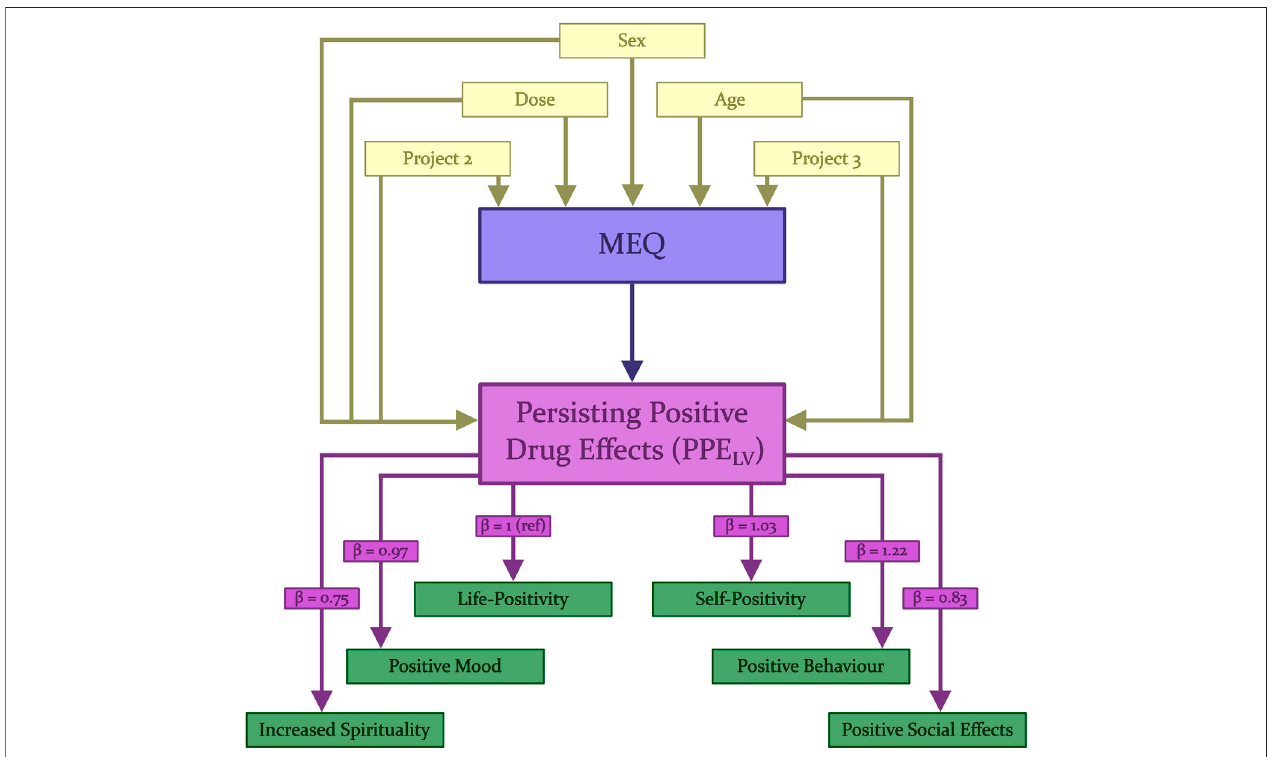
FIGURE1| LatentVariable Model. Schematic diagram describing the structure oftheLVM used intheanalysisofthe relation between MEQand thelatent variable PPE LV . “ MEQ ” (blue) represents either the MEQ total score or one of the four different subscales of the MEQ. Each was analysed using a different model; therefore, regressionoutputsarenotreportedinthis fi gureandareinsteadreportedin Table2 .LoadingsoftheindividualpositivesubscalesofthePEQarestablebetweenmodels and are thus reported on the lines between PPE LV and the subscales. Loadings of co-variates are reported in Supplementary Table S3 .